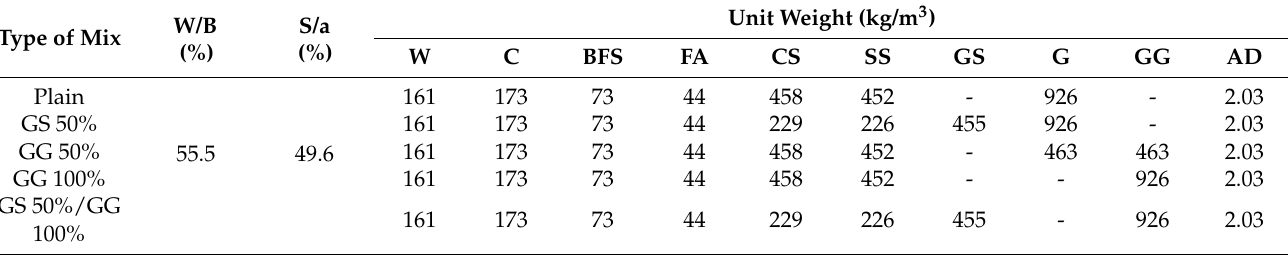
Table 9. Mix proportion of the rural-road pavement